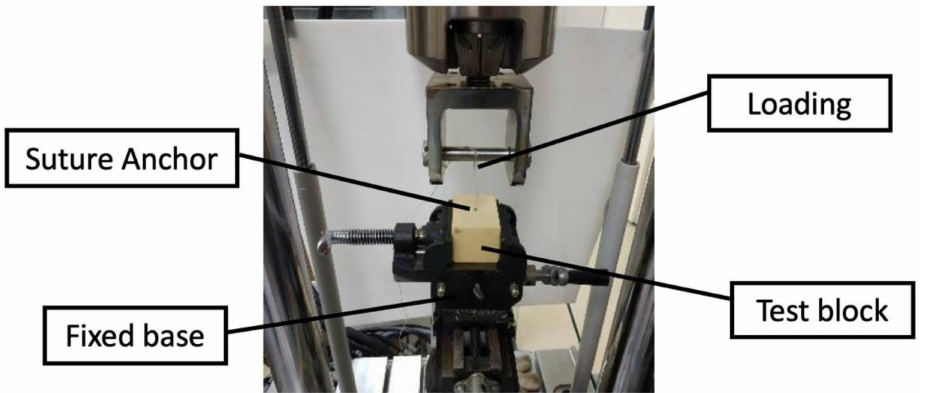
Figure 6. Setup of the pullout test. The test block was stabilized by the clamp, which was fixed to the base. The suture anchor with the suture applied on was inserted into the test block. The suture was then fixed to the testing machine to provide the axial force for pullout.